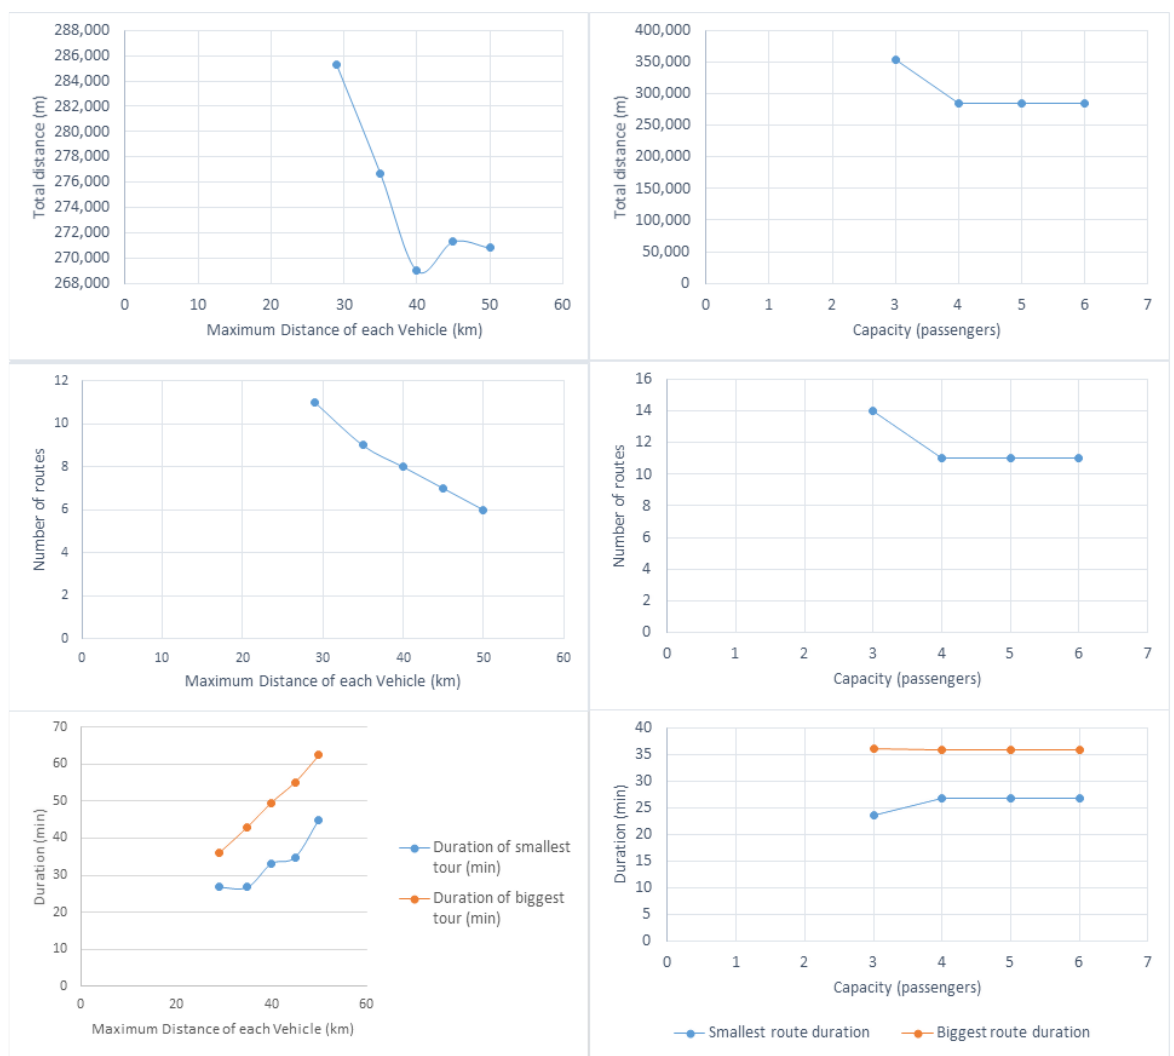
Figure 6. Changes in objective function ( top ), number of routes ( center ) and route duration ( bottom ) due to maximum range ( left ) and capacity ( right ).